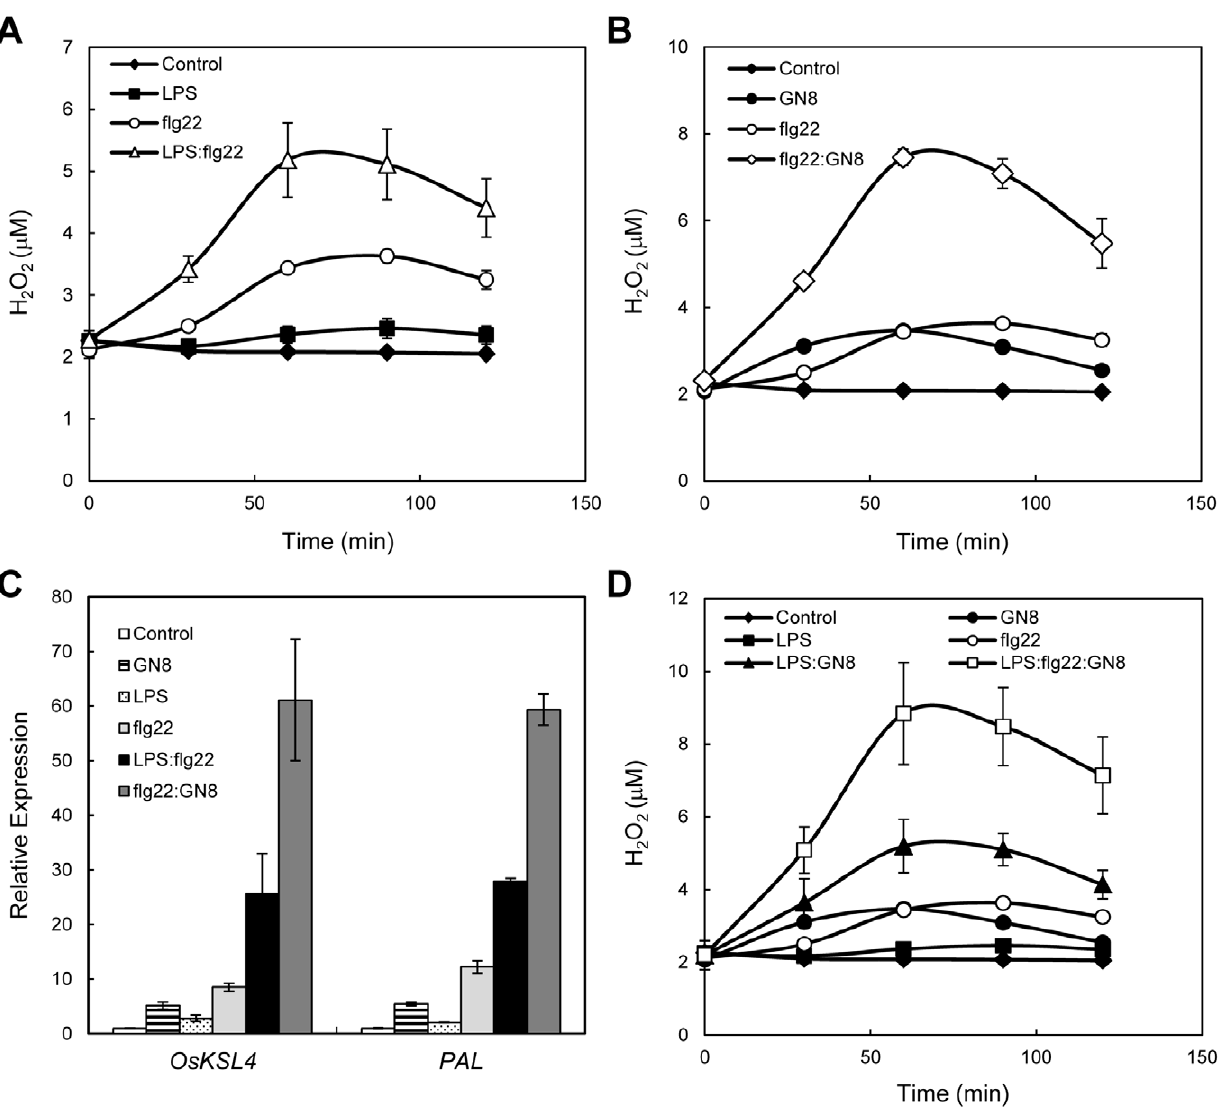
Figure 4. Synergistic enhancement of defense responses by different combination of MAMPs. (A) Synergistic induction of ROS generation by simultaneous treatment of LPS (0.1 m g/ml) and flg22 (1 ng/ml). (B) Synergistic induction of ROS generation by simultaneous treatment of GN8 (0.08 ng/ml) and flg22 (1 ng/ml). (C) Synergistic induction of defense gene expression by LPS:flg22 or GN8:flg22. (D) Comparison of ROS generation induced by simultaneous treatment with two or three MAMP elicitors. Experimental conditions were the same to Fig.